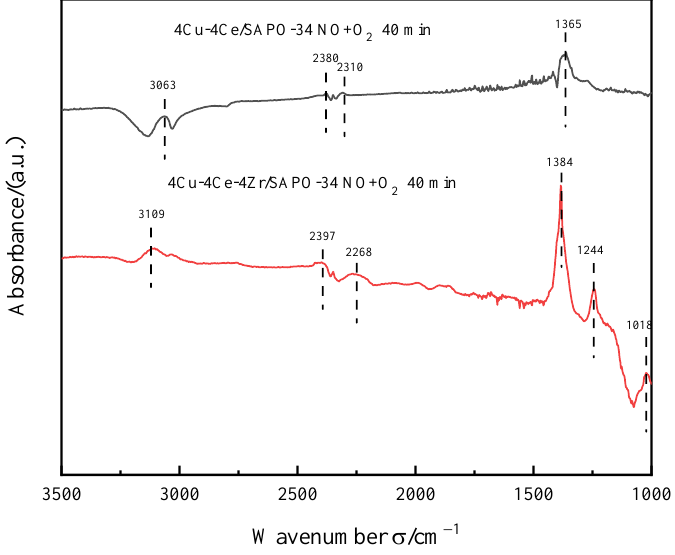
Figure 8. In situ DRIFTS of NO+O 2 adsorbed over the 4Cu-4Ce-4Zr/SAPO-34 and 4Cu-4Ce/SAPO- 34 catalyst.